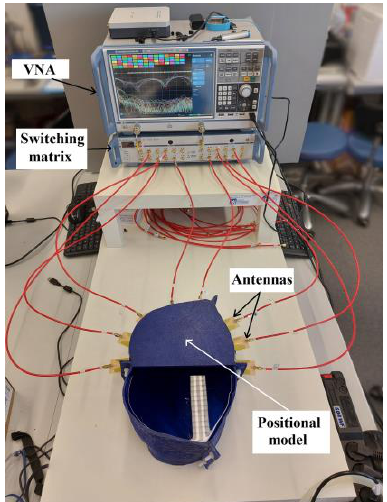
Figure 12. The experimental setup was used for measurements with the description of the individ- ual parts.